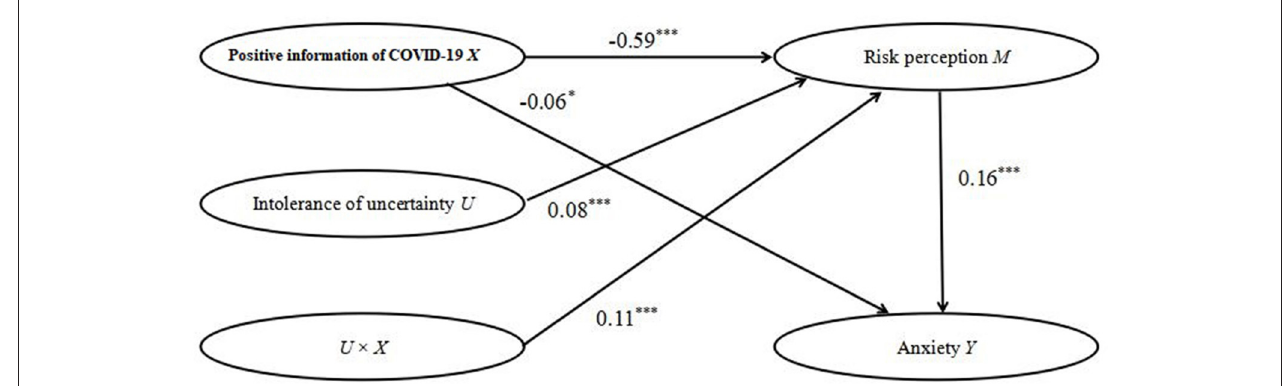
FIGURE 2 | Moderated mediation result. * P < 0.05, *** P < 0.001.